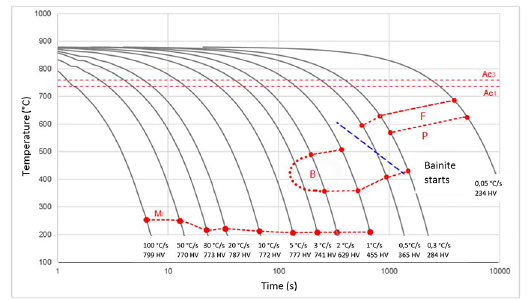
Figure 6. CCT diagram for Nb microalloyed steel used in this study (Nb)